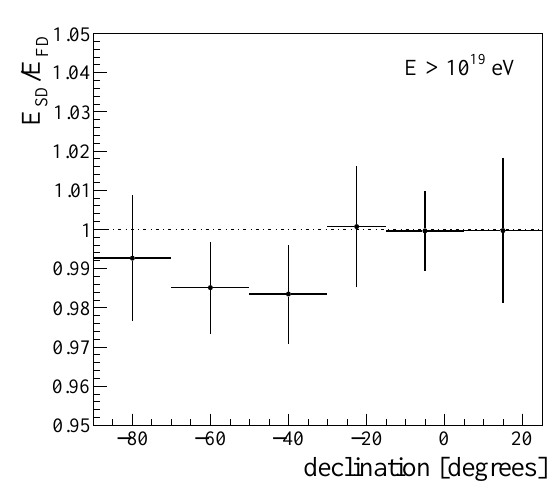
Figure 9. Ratio of the energies reconstructed by the Auger SD and FD plotted versus the event declination.